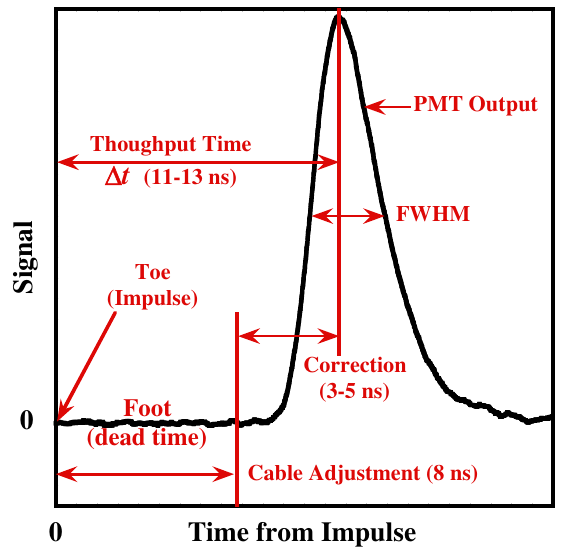
FIG. 2. A generic IRF for nTOF detectors with various features noted: an initialization time (toe), a dead time (foot) for internal light transit, and a peak of the PMT output. The throughput time Δ t is defined as the time between initialization and the peak of the PMT output. For the detectors used for shot 2584, the dead time was at least 8 ns.